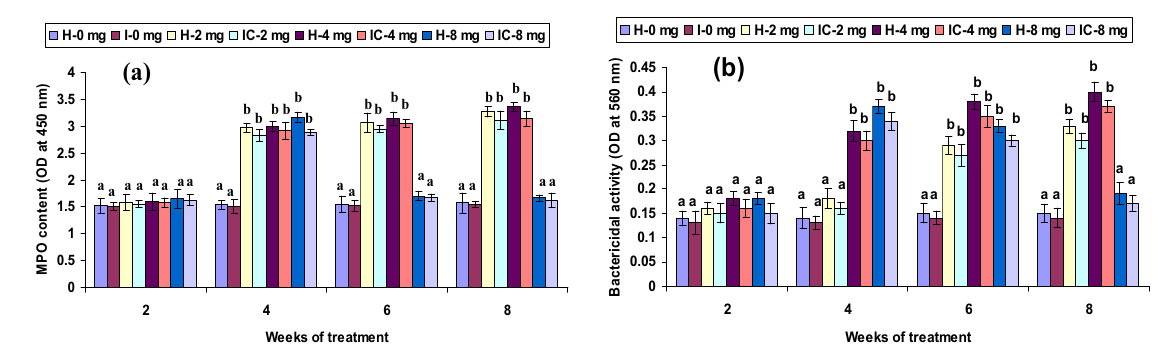
Figure 4. ( a ) Myeloperoxidase (MPO) content and ( b ) bactericidal activity of catla (n = 6) head kidney leucocytes against A. hydrophila . H healthy, I infected. Data are expressed as mean ± SD and the statistically significant difference ( P < 0.05) between mean values as indicated in different letters in each column.